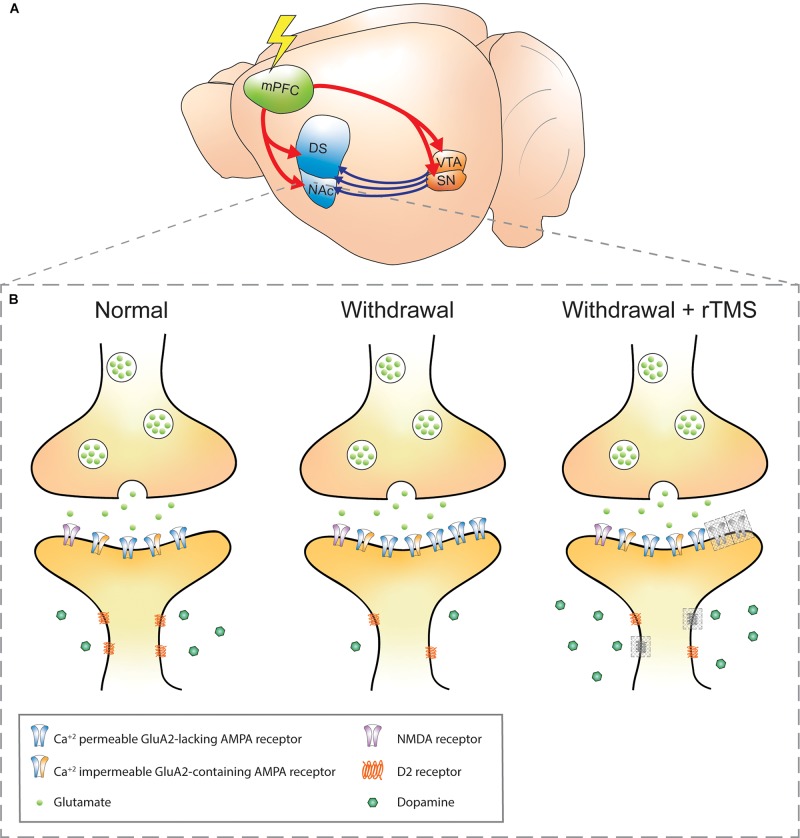
Schematic of addiction circuitry and the synaptic changes between an efferent mPFC glutamatergic neuron axon terminal and accumbal D2 receptors expressing MSN dendrite. (A) Rodent brain with glutamatergic efferents (red) projecting to the striatum and ventral midbrain nuclei. Dopaminergic projections (blue) from the VTA and SN project to the striatum. The rodent mPFC is comparable to the DLPFC in humans, a common site of rTMS stimulation in addiction (Diana et al., 2017). (B) Axon terminal of a mPFC glutamatergic neuron synapsing onto a D2 receptors-expressing MSN in the NAc in normal, withdrawal, and withdrawal + rTMS (proposed) treatment brain state. During cocaine or methamphetamine withdrawal, Ca2+-permeable GluA2-lacking AMPA receptors are upregulated in the NAc, which increases the sensitivity of NAc neurons to excitatory inputs and is a requirement for cue-induced drug craving (Cornish and Kalivas, 2000; Conrad et al., 2008; McCutcheon et al., 2011b). Also during withdrawal, dopaminergic signaling via volume transmission is reduced (i.e. hypodopaminergic tone), and downregulation of dopamine D2 receptors is observed, both of which contribute to reduced inhibitory feedback signals (Nutt et al., 2015; Volkow and Morales, 2015). These changes are linked to impulsivity and compulsive drug seeking (Lee et al., 2009; Moeller et al., 2018). The combination of reduced dopaminergic and glutamatergic signaling also contributes to aberrant plasticity during drug withdrawal (Huang et al., 2017). Gray-shaded boxes in the “withdrawal + rTMS” MSN dendrite represent proposed and speculative changes based on existing literature: 1. Upregulation of D2 receptors: rTMS over the PFC has been shown to alter extracellular glutamate and dopamine concentrations in the NAc, likely due to indirect activation of dopaminergic midbrain structures that project to the NAc. D2 receptor expression has been shown to be upregulated in the PFC following five daily sessions of rTMS in healthy mice (Etiévant et al., 2015). Chronic rTMS may therefore normalize the downregulation of D2 receptors in the NAc during withdrawal (D2 receptors, gray shading). 2. Insertion of GluA1-containing AMPA receptors: this has been observed within excitatory postsynapses of organotypic hippocampal slice cultures (Vlachos et al., 2012) and PFC of awake animals (Etiévant et al., 2015); however, it is not known whether this effect also occurs within NAc postsynapses and whether they also contain the GluA2 subunit (AMPA receptor, gray shading). Furthermore, it is not known whether the GluA2-lacking AMPA receptors that accumulate during withdrawal are affected by rTMS. mPFC, medial prefrontal cortex; DS, dorsal striatum; NAc, nucleus accumbens; VTA, ventral tegmental area; SN, substantia nigra; NMDA, N-methyl-D-aspartate; AMPA, α-amino-3-hydroxy-5-methyl-4-isoxazolepropionic acid; MSN, medium spiny neuron; rTMS, repetitive transcranial magnetic stimulation.